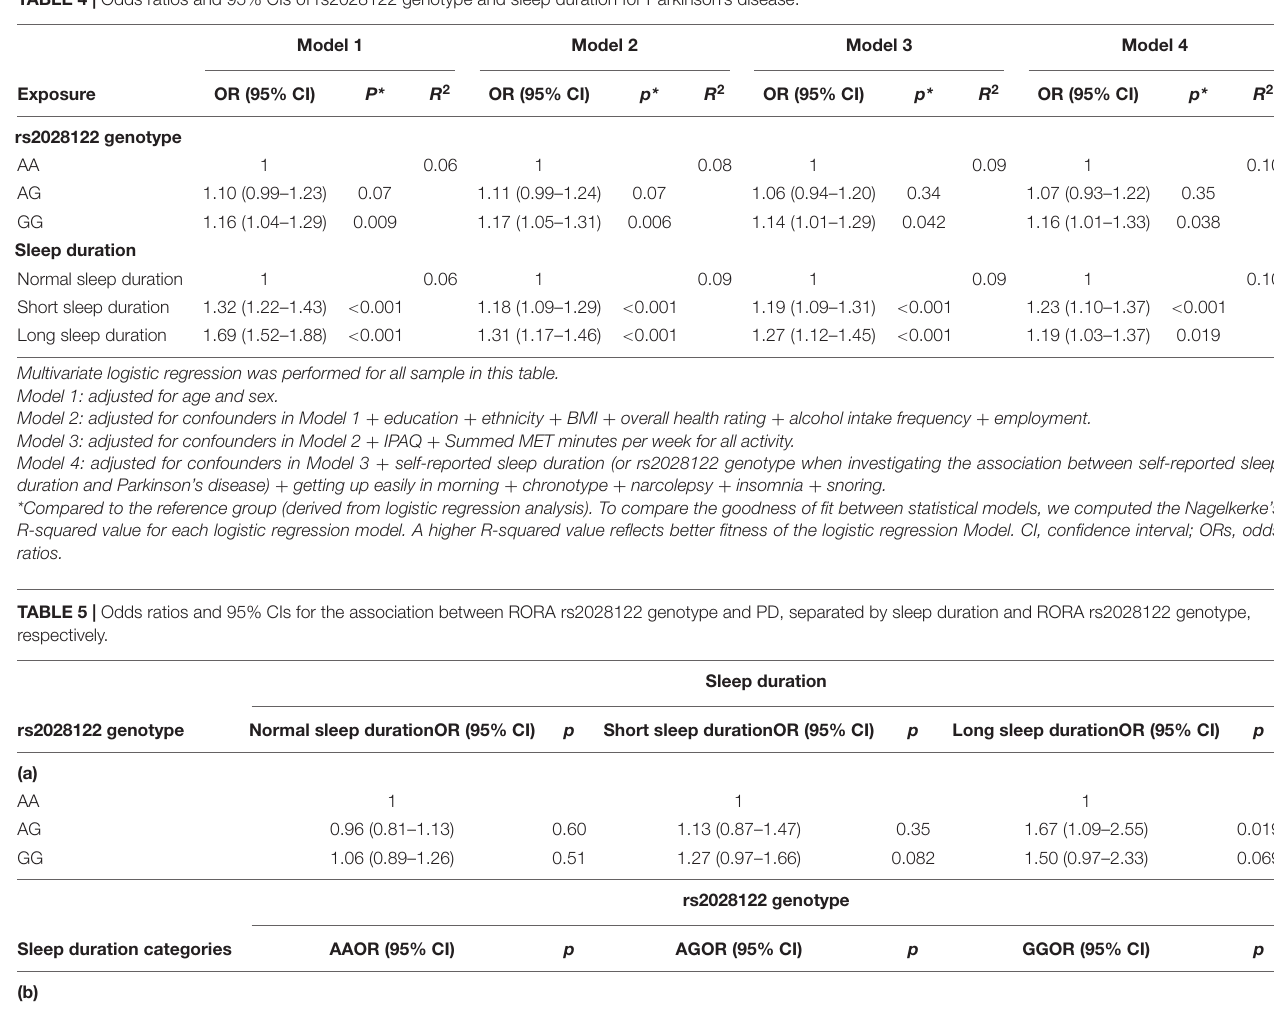
TABLE 4 | Odds ratios and 95% CIs of rs2028122 genotype and sleep duration for Parkinson’s disease.